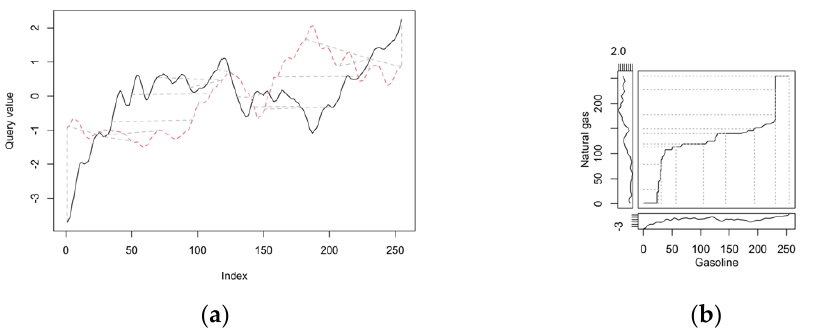
Figure 12. Alignment plots for gasoline and natural gas for the second subperiod. ( a ) Two-way, ( b ) Three-way. On the two-way plot the black solid line for gasoline, the red dashed line for natural gas. Source: own elaboration on the basis of data from www.stooq.com (accessed on 19 April 2021).